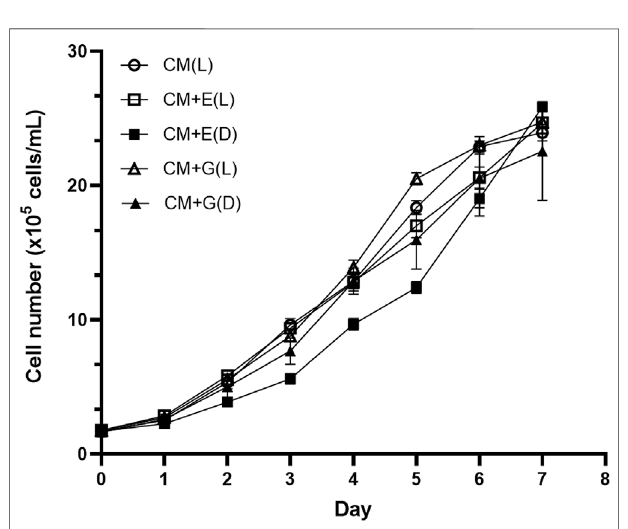
FIGURE 2 | Growth of E. gracilis 815 under different conditions. Abbreviations: CM(L), CM medium + light; CM + E(L), CM medium + ethanol (light); CM + E(D), CM medium + ethanol (dark); CM + G(L), CM medium + glucose (light); CM + G(D), CM medium + glucose (dark). Values correspond to the mean ± standard deviation (n = 3).